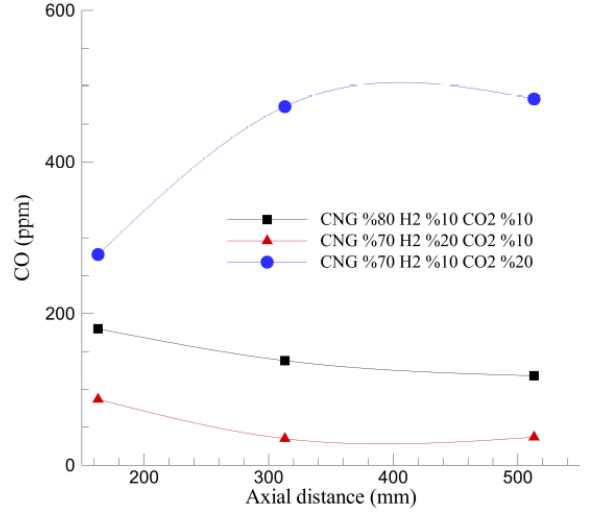
Figure 12: Axial CO 2 concentration profiles (Swirl number: 0.6, 0.8).